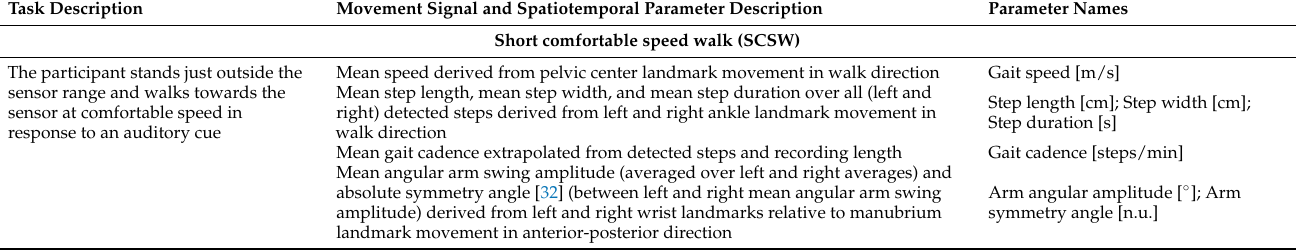
Table 2. Motor task descriptions, information on respectively extracted movement signals and spatiotemporal parameters as well as parameter names. Abbreviations: AP: anterior-posterior; n.u.: unitless; RR: Romberg ratio.